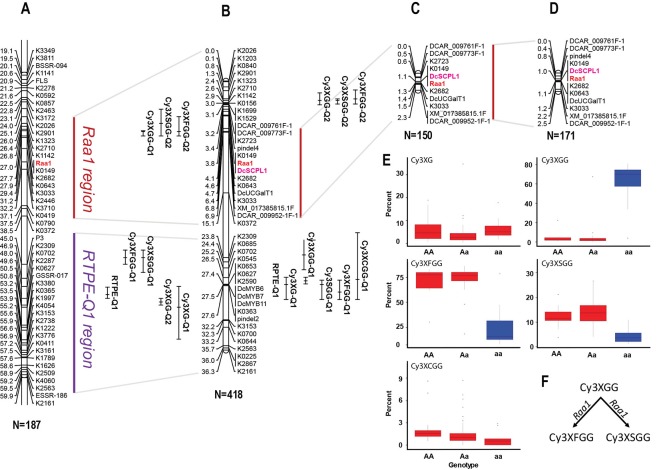
Genetic mapping of anthocyanin pigment traits on chromosome 3 of several carrot populations. (A) QTLs for RTPE, root anthocyanin pigments (Cy3XG, Cy3XGG, Cy3XSGG, Cy3XFGG, and Cy3XCGG) and Raa1, mapped in the original framework linkage map published by Cavagnaro et al. (2014). The complete linkage group 3 is represented in
Supplementary Figure S3
. (B) High-resolution mapping in the RTPE-Q1 and Raa1 regions using a larger 70349 population. (C, D) The Raa1 locus, conditioning anthocyanin acylation, was mapped in populations 5392 (C) and 5394 (D) using scores (HAA and LAA) from purple samples. Connecting gray lines indicate the flanking markers of the map region further analyzed in this work. Bars to the right of the linkage groups represent support intervals of the QTLs. The anthocyanin candidate acyltransferase DcSPL1 is denoted in bold purple letters. Population size is indicated in parenthesis under each linkage group. (E, F) Relative content of each cyanidin derivatives based on the allele score at marker K0149. (F) Diagram showing the function associated with the Raa1 locus.